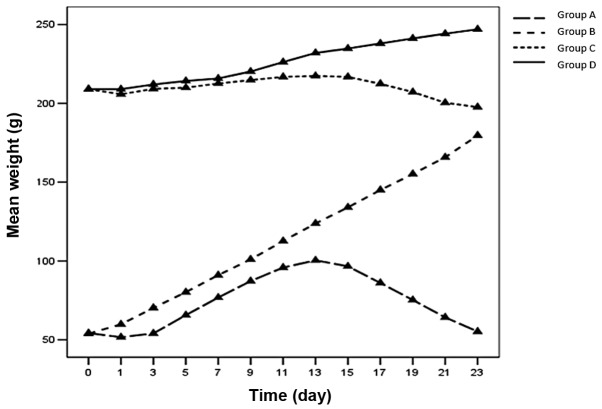
Weight gain. The rats in groups A and C exhibited a ‘decrease-increase-decrease’ mode of weight gain.